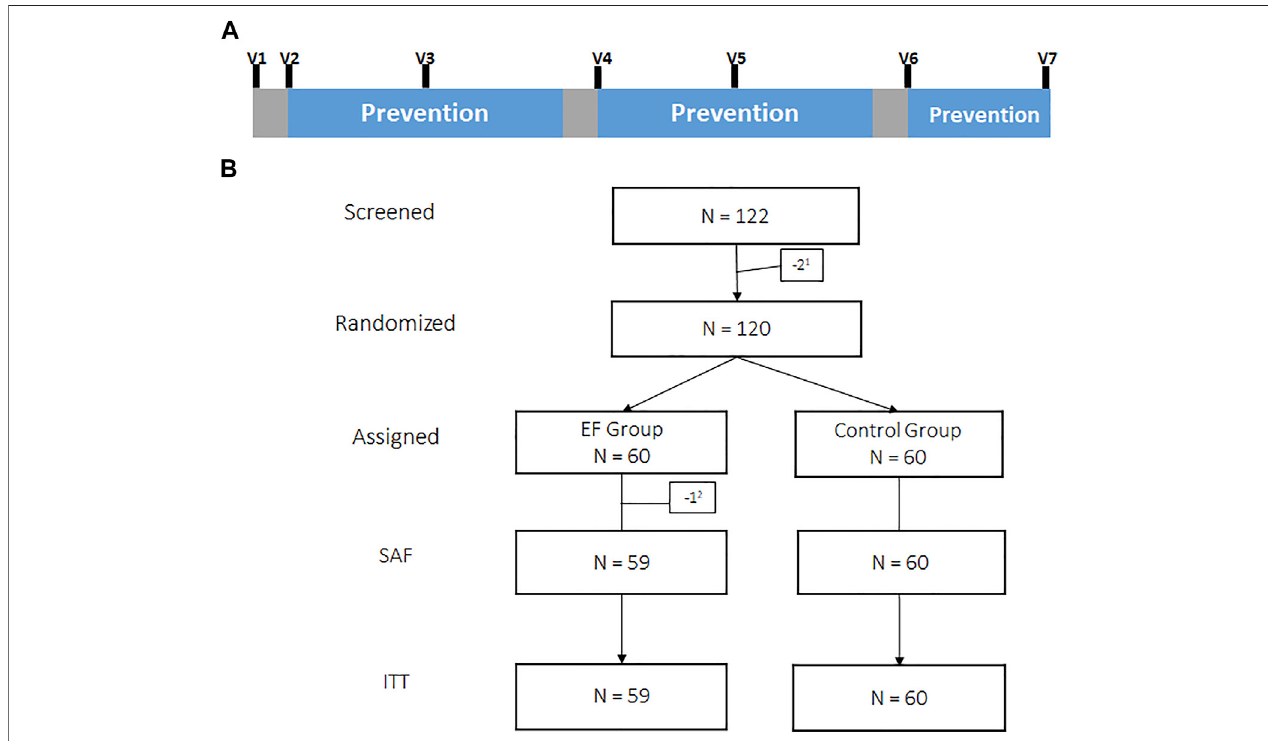
FIGURE1| IllustrationoftheinterventionschemeshowingphasesofEFprevention(blue)interruptedbyphasesofbreaks(grey)withstudyvisits(V1-V7)forroutine virus sampling (A) . Subject disposition tree. 1 Screening-failure, 2 Withdrawal of consent prior intake of study medication, SAF: Safety group, ITT: Intention to treat group (B)